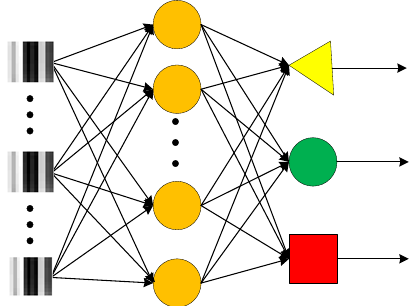
Figure 12. The structure of the MLP.